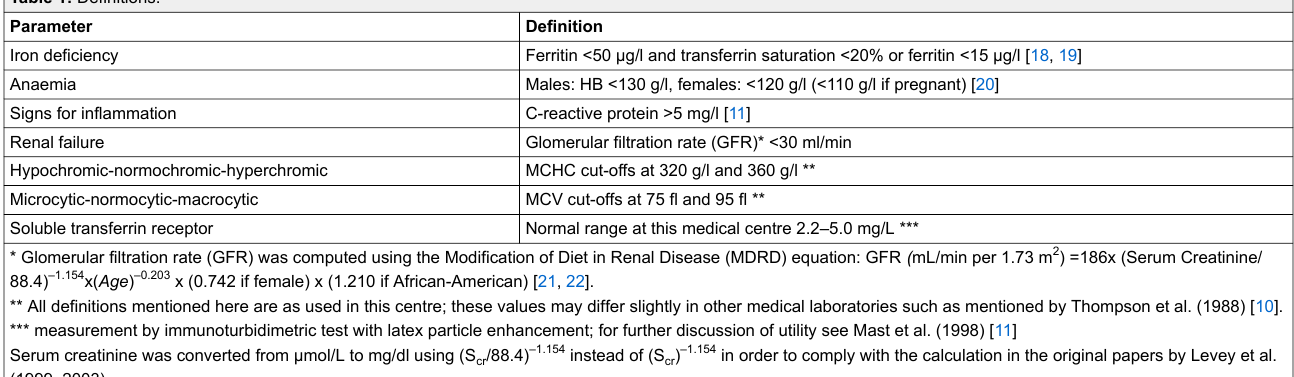
Table 1: Definitions.